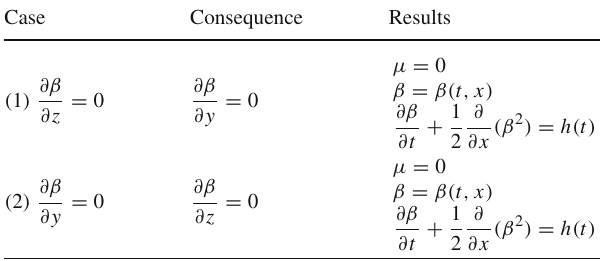
Table 1 Summary of results for the warp drive spacetime having dust matter content